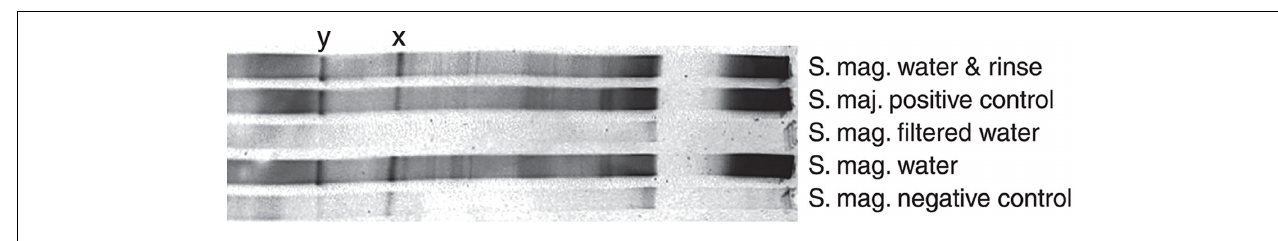
from an acidic fen (FR726177) with 95% similarity. Sequence y (HQ651183) was identical to a Methylocystis sequence previously found on Finnish peatlands (GQ468279, GQ279344, FJ930091) and Sphagnum mosses